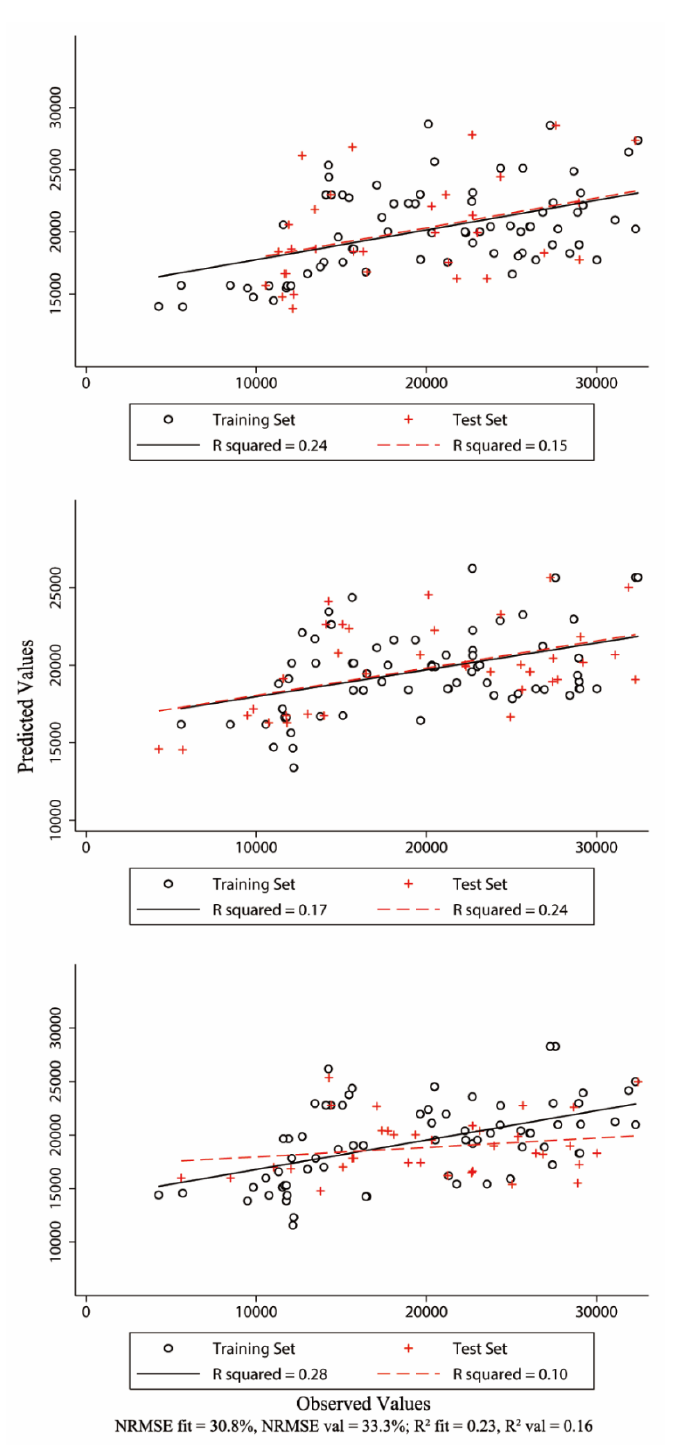
Figure 4. Results of 3-fold cross-validation for the sorghum–sudangrass hybrid yield prediction model, showing fit of predicted yield values for both training and test sets in relation to observed yield values (o refers to the training set, + refers to the test set).